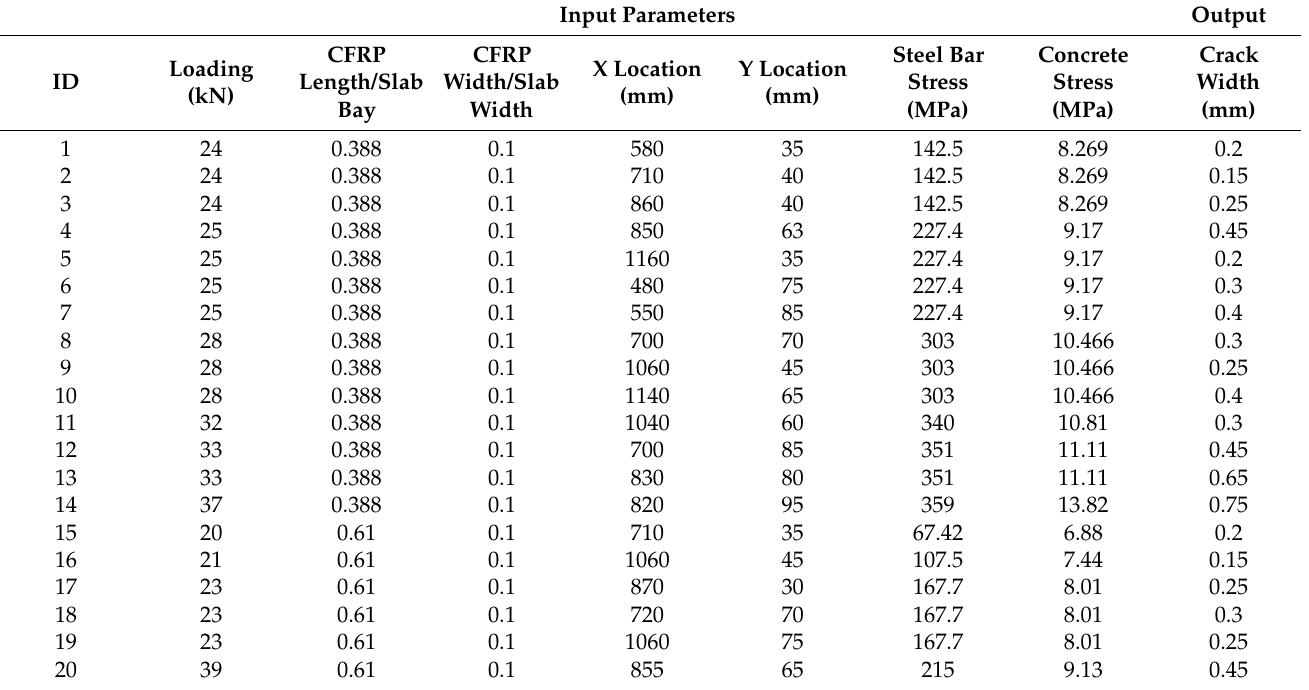
Table A1. The dataset used in this